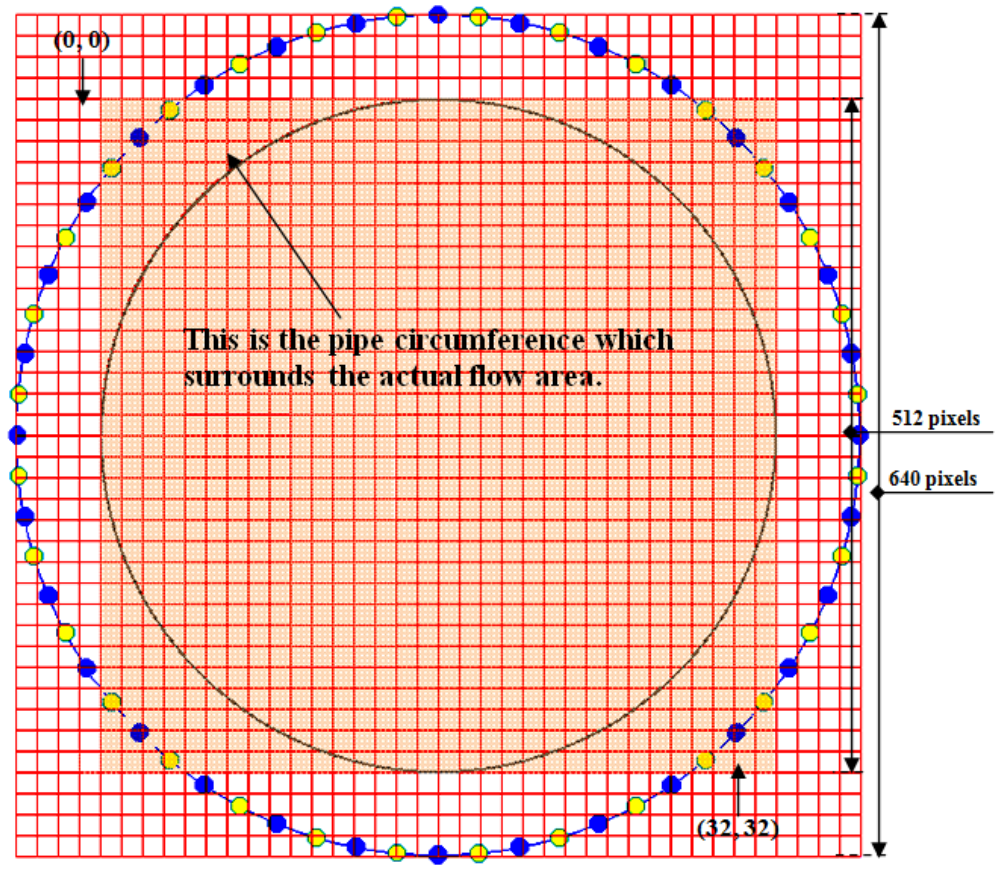
Figure 6. The actual flow image